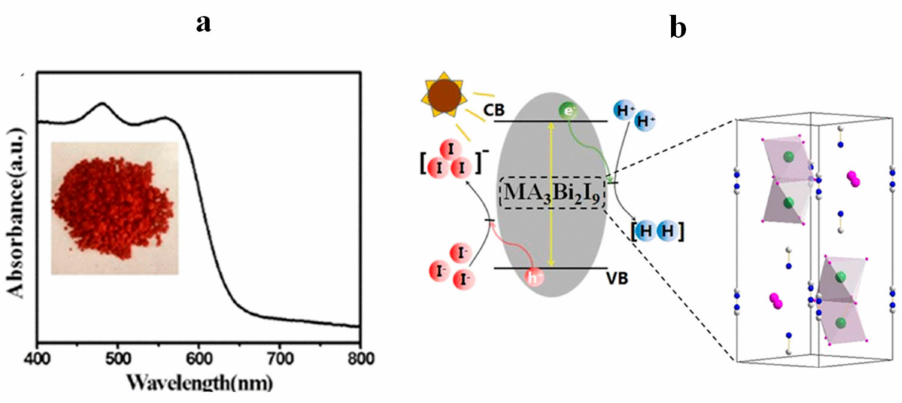
Figure 20. UV-Vis spectra ( a ) and schematic representation ( b ) of the MA 3 Bi 2 I 9 powder for H 2 evolution. Reprinted with permission from [309], Copyright (2019) American Chemical